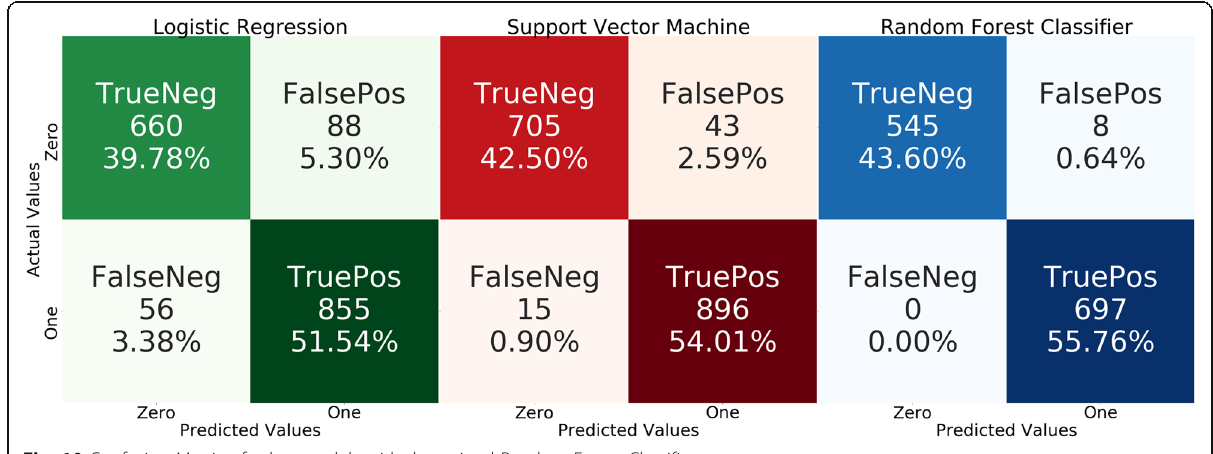
Fig. 10 Confusion Matrix of other models with the trained Random Forest